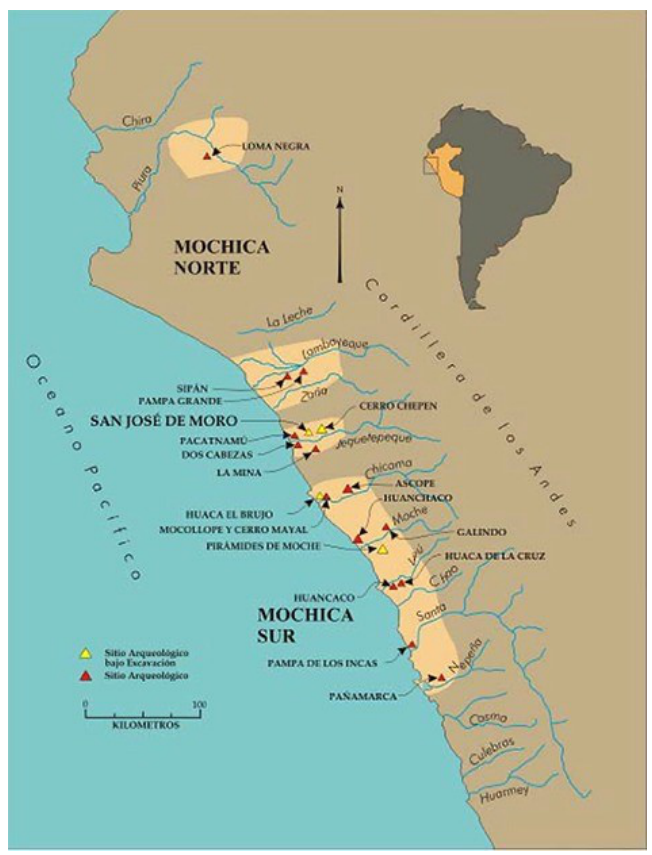
Figure 1. Map of current day Peru, showing the Moche pre-Colombian